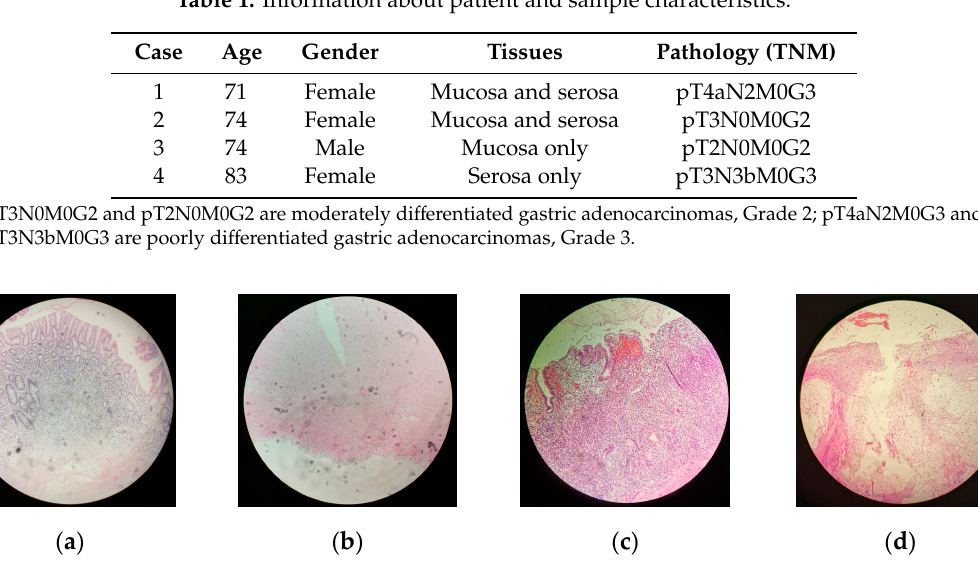
Table 1. Information about patient and sample characteristics.